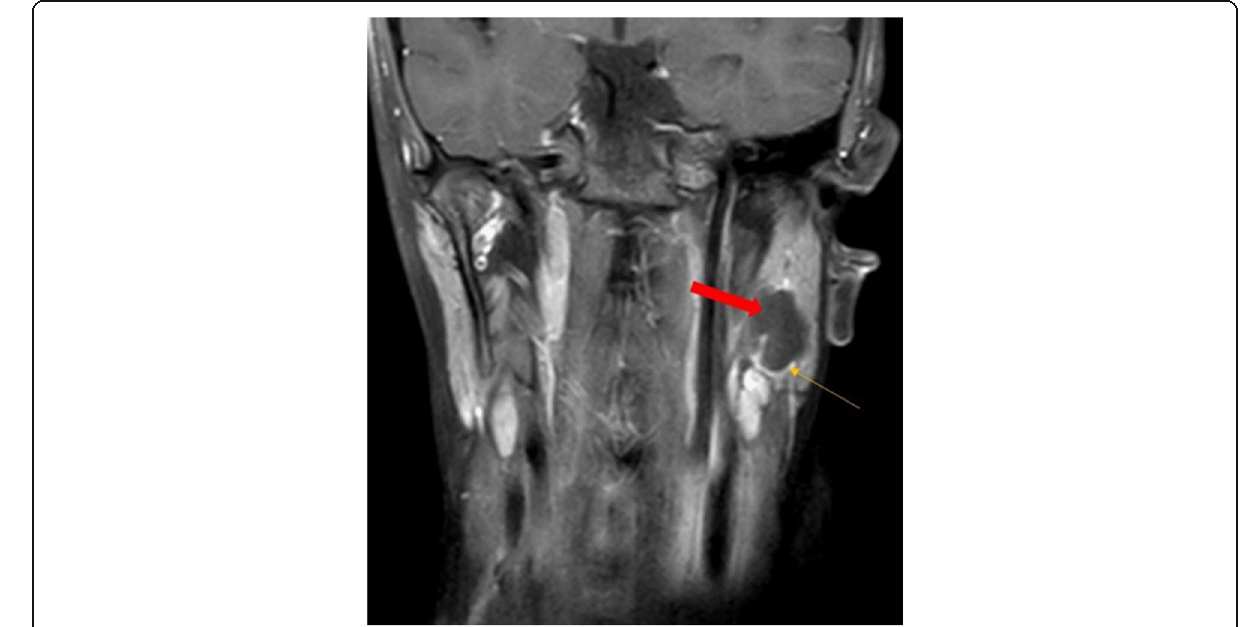
Fig. 3 Cervical MRI; coronal T1W sequence after gadolinium injection: nonenhancing cystic formation